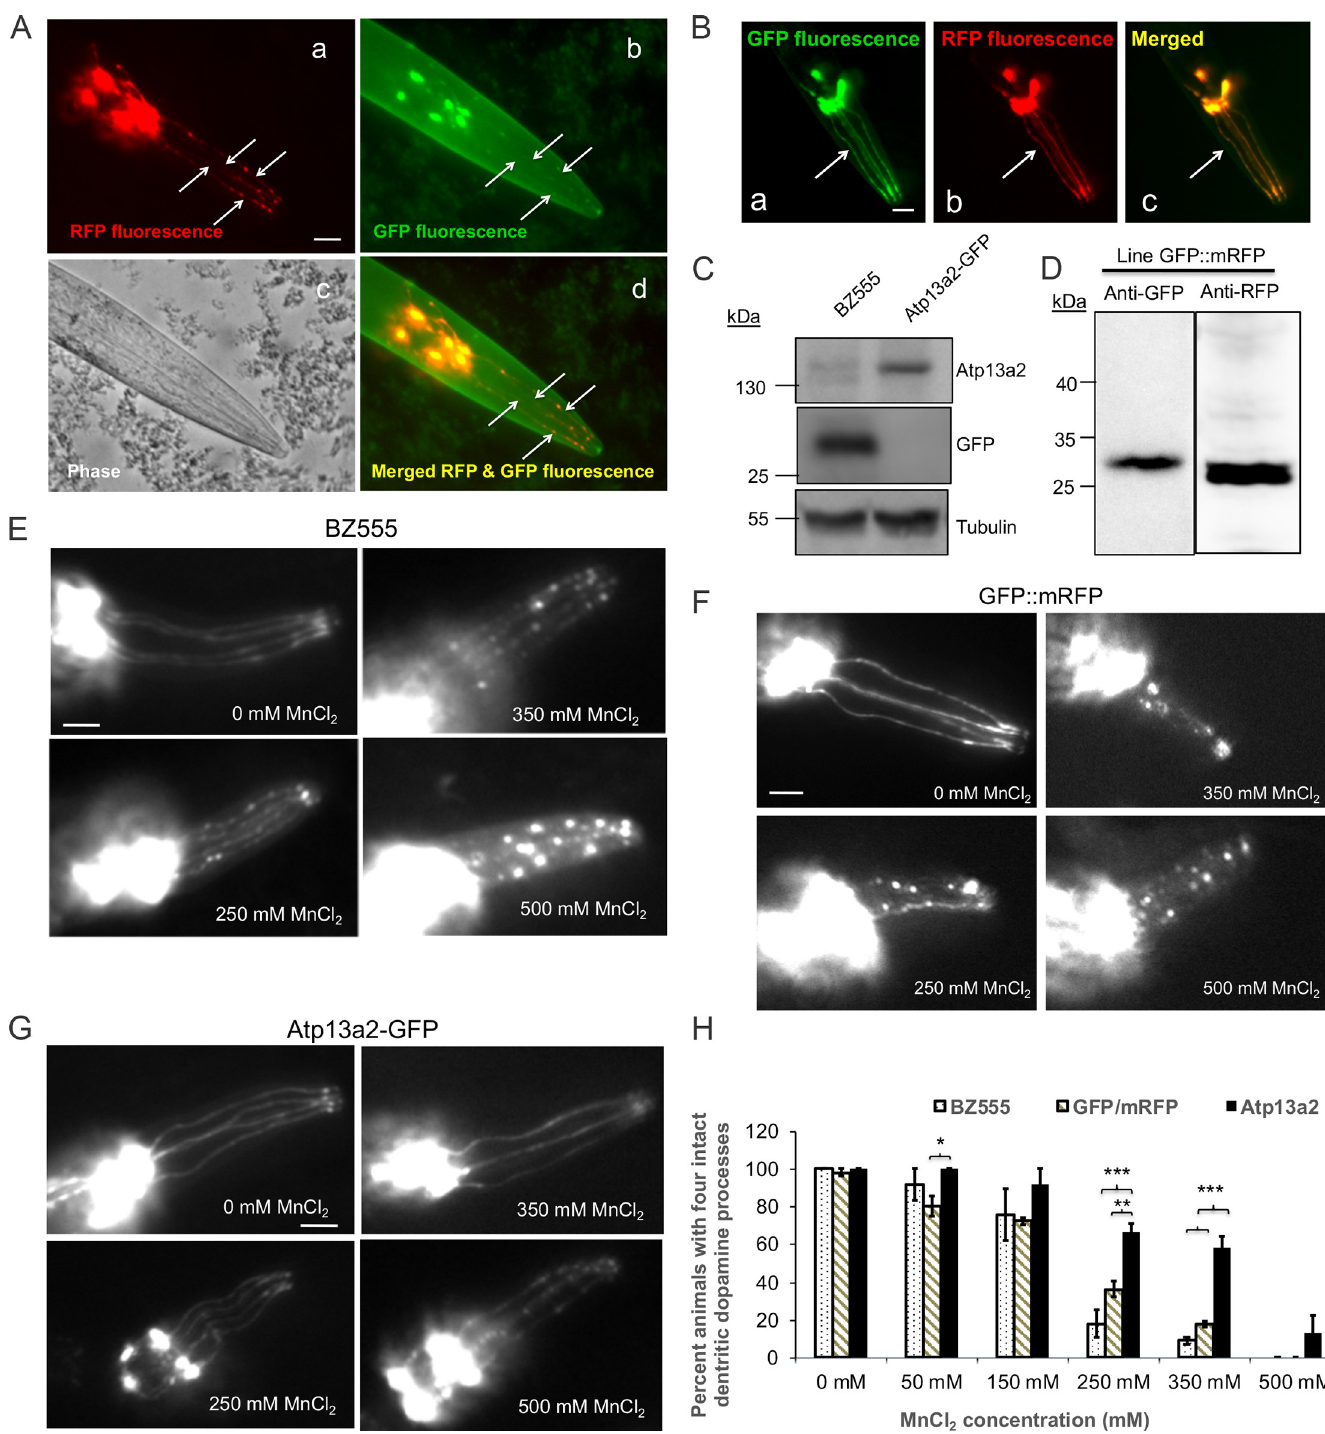
Fig 5. Nematodes expressing GFP-tagged Atp13a2 exhibit higher resistance to manganese induced dopamine neuron degeneration. (A) Double fluorescence microscopy demonstrating visual detection of RFP and GFP fluorescence in dopamine neuron processes (indicated with arrows) in the head of the C . elegans line coexpressing dat-1p:mRFP and dat-1p:Atp13a2-GFP. The phase contrast image of the head region is also shown, together with the image produced after merging the red and green fluorescent images. Because of its brighter fluorescence the RFP fluorescence was used to monitor dopamine neuron degeneration after manganese exposure. Bar, 25 μ m. (B) Fluorescent images of the head region of the nematode line coexpressing dat-1 promoter driven expression of GFP (a) and mRFP (b) and the result of merging the two fluorescent proteins (c). The arrow shows clear colocalization of GFP and mRFP fluorescence in dopamine neurons. (C) Immunoblots of C .